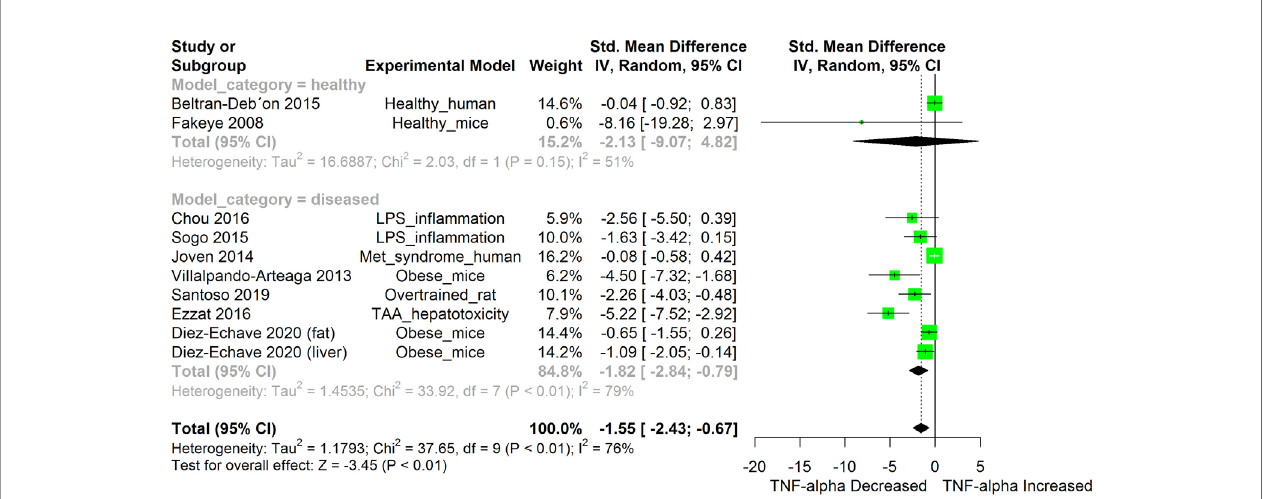
FIGURE 8 | Meta-analysis and forest plot of the effect of HS administration on TNF- a . The meta-analysis was sub-grouped by health status (i.e diseased or healthy state). The standardized mean difference (SMD), which is an estimate of the effect size, is presented as a square on the forest plot, for each study and as a diamond for the pooled estimate of each subgroup or overall studies. The overall pooled SMD for all included studies is shown in the bottom section of the forest plot. SMD data points that are lower than zero signify that treatments with HS lowered the level of the biomarker while those greater than zero signify that HS treatment caused an increase in the levels of the biomarker. The statistical signi fi cance of the pooled estimate is indicated by the Z test of signi fi cance. LPS, Lipopolysaccharide; Met, Metabolic; TAA,